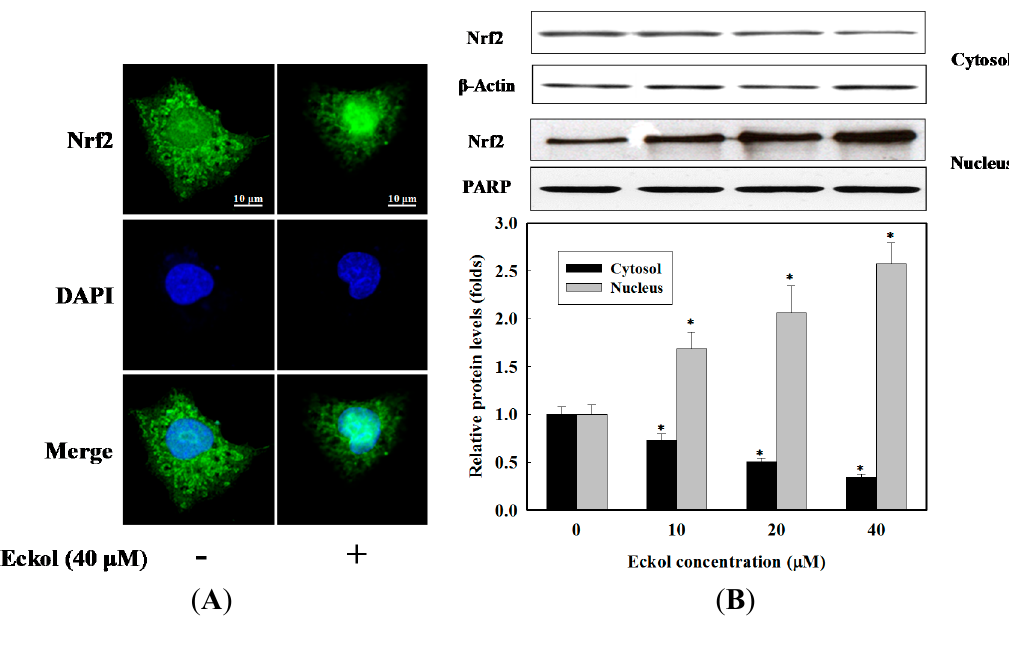
Figure 4. Effect of eckol on the translocation and activation of Nrf2. ( A ) Cells were pretreated with or without 40 μ M eckol for 1 h. The cells were fixed and immunostained with anti-Nrf2 antibody for 2 h. The nuclei were stained with DAPI and the images were captured by confocal microscopy (×100); ( B ) Cells were treated with various concentrations of eckol for 1 h. Cytosolic and nucleic fractions were prepared and analyzed by Western blot using corresponding antibodies; ( C ) Cells transfected with ARE promoter-containing luciferase DNA were treated with various concentrations of eckol for 1 h. Values are the mean ± SD of three independent experiments. * p < 0.05 indicates significant differences compared to the control